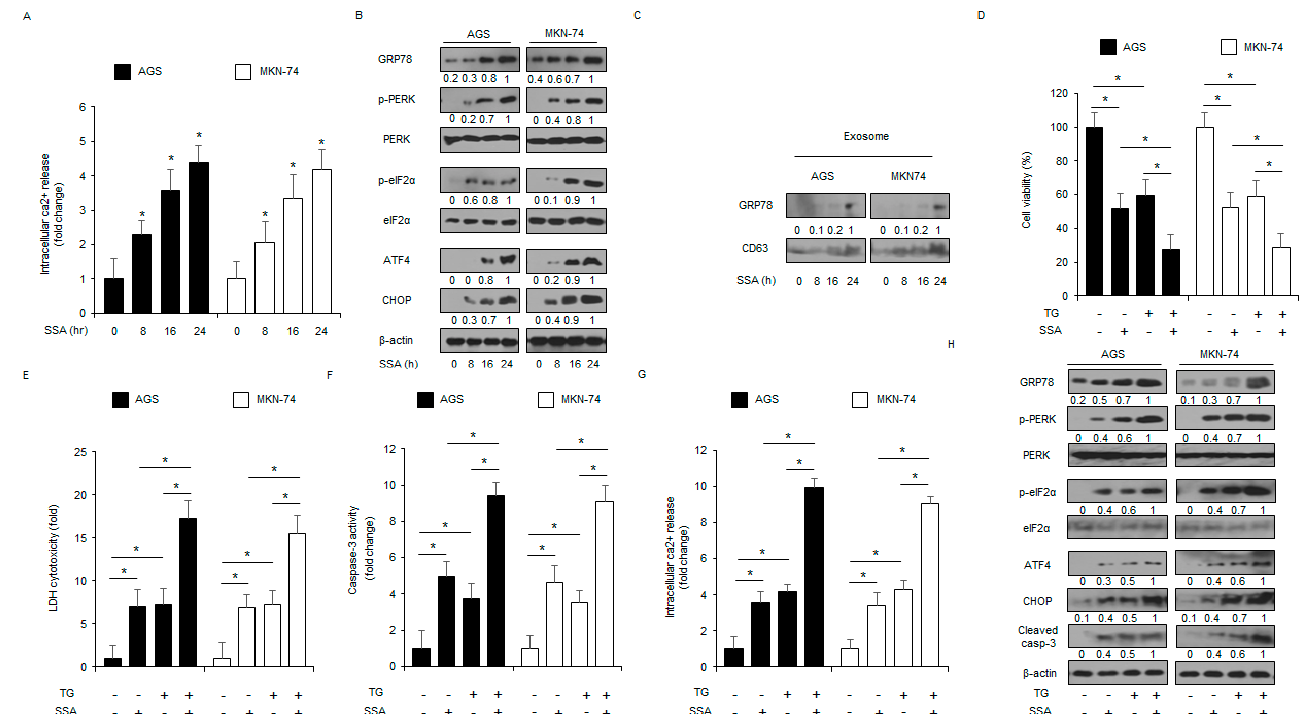
Figure 3. SSA induces ER stress in GC cells. ( A , B ) AGS and MKN-74 cells were treated with SSA (10 μ M) for the indicated times and an intracellular Ca 2+ assay was performed; *, p < 0.05. ER stress markers (GRP78, p-PERK, PERK, p-eIF2 α , eIF2 α , ATF4, and CHOP) were measured by Western blot assay. Β -actin was used as a protein loading control. ( C ) AGS and MKN-74 cells were treated with SSA (10 µ M) for the indicated times, and then exosomes (30 µ g) were collected from the cell supernatant. Total exosomes were determined by Western blotting using the exosome marker, CD63, and the ER stress marker, GRP78. ( D – H ) Cell viability, LDH release, caspase-3 activity, intracellular Ca 2+ , and GRP78, p-PERK, PERK, p-eIF2 α , eIF2 α , ATF4, CHOP, and cleaved caspase-3 levels were determined in thapsigargin (TG; 3 µ M, 24 h) and SSA (10 µ M, 24 h)-treated AGS and MKN-74 cells; *, p <